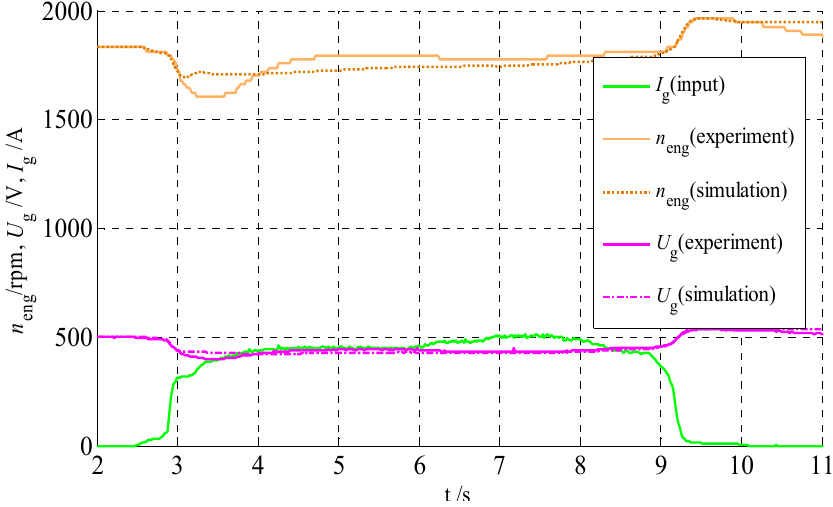
Figure 3. Test and simulation results of the equivalent